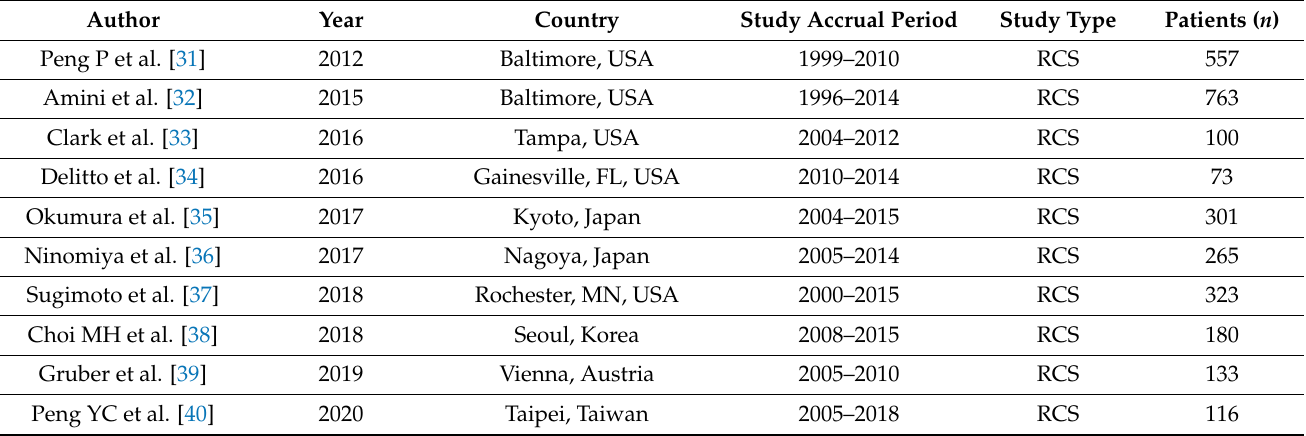
Figure 1. Studies’ inclusion flowchart according to the Preferred Reporting Items for Systematic Reviews and Meta-Analyses (PRISMA) guidelines [28]. Table 2. Characteristics of the studies included in the systematic